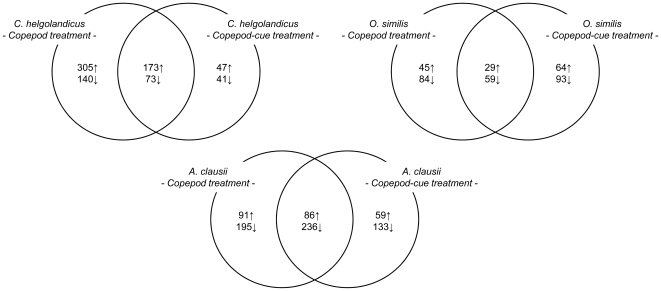
Venn diagram of responsive ESTs after 48 h exposure to different copepod species and cues.Numbers of responsive ESTs are separated in up (↑) and down (↓) regulated ESTs. The intersections displays the number of ESTs regulated in both treatments. Identification of regulated ESTs is based on microarray hybridizations and evaluated with a Student's t-test against a control treatment with n = 3 and p<0,05.